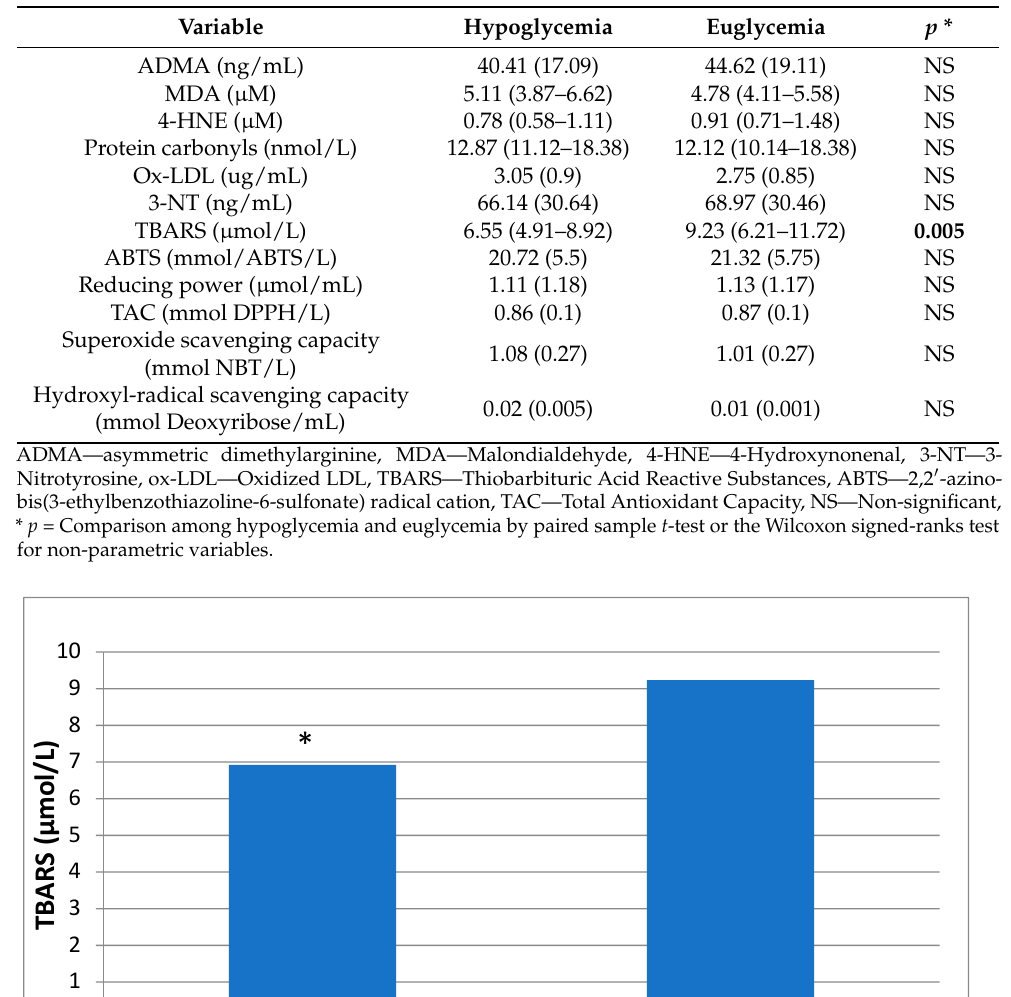
Table 2. Comparison of oxidative stress biomarkers and antioxidant capacity indices between hy- poglycemia and euglycemia [mean ± SD for normally distributed variables or median (IQR) for non- normally distributed variables].